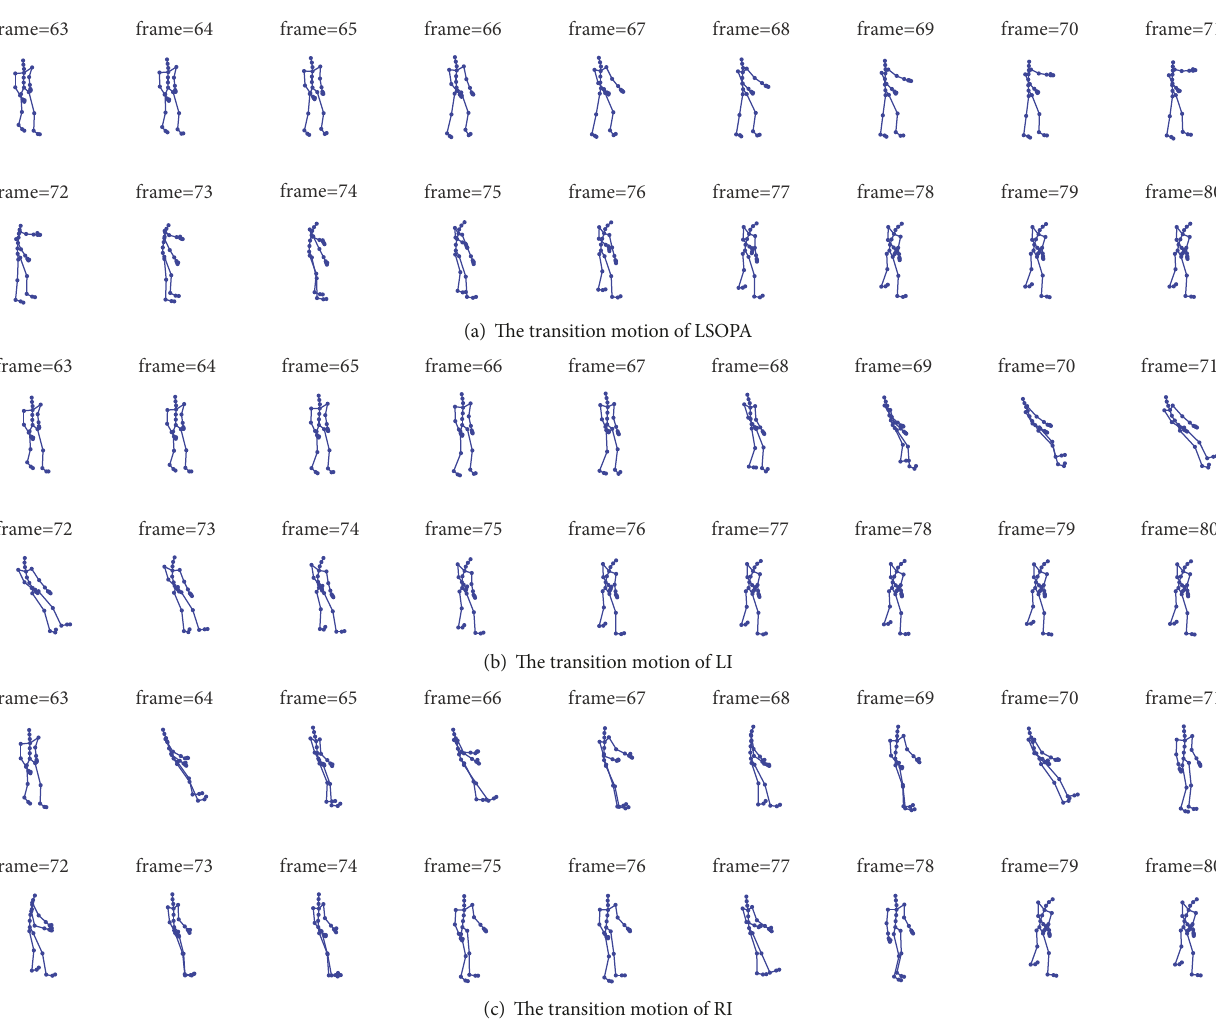
Figure 4: The visual evaluation of the